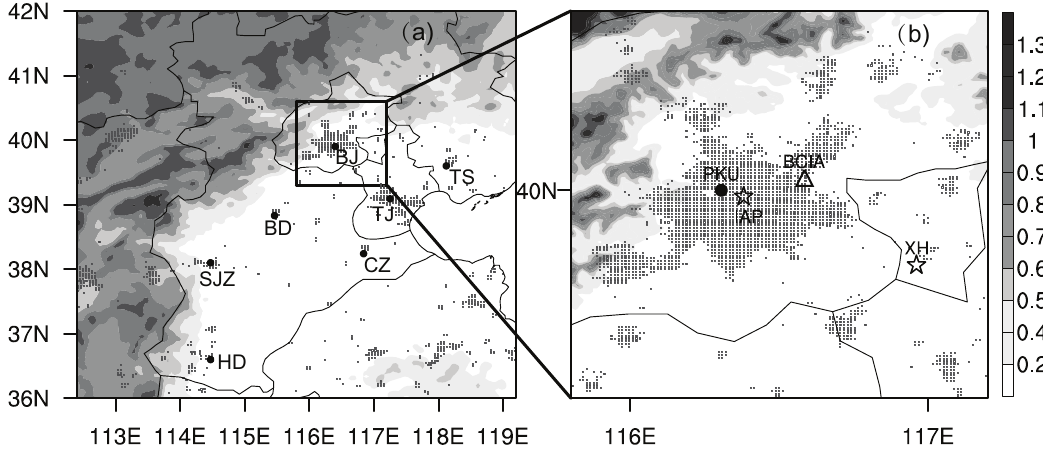
Fig. 1. Terrain height (km) and urban distribution (dotted region) around Beijing. (a) Black dots represent major cities in the North China Plain. BJ, TJ, BD, SJZ, HD, CZ, and TS represent Beijing, Tianjin, Baoding, Shijiazhuang, Handan, Cangzhou, and Tangshan, respectively. (b) Loci of the BCIA, PKU, AERONET Beijing (IAP), and Xianghe (XH) sites.